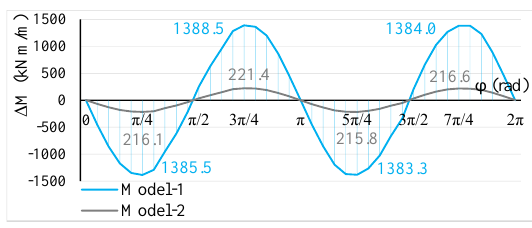
Figure 11. Distribution of moments comparing the impact of fixed and absorbing boundary